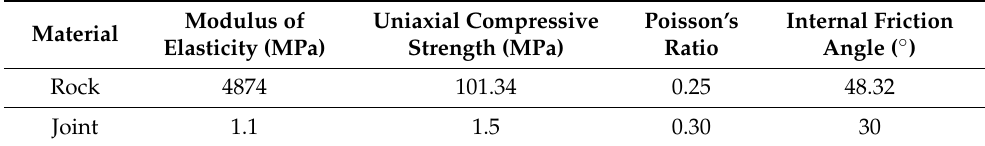
Table 4. Mechanical parameters of